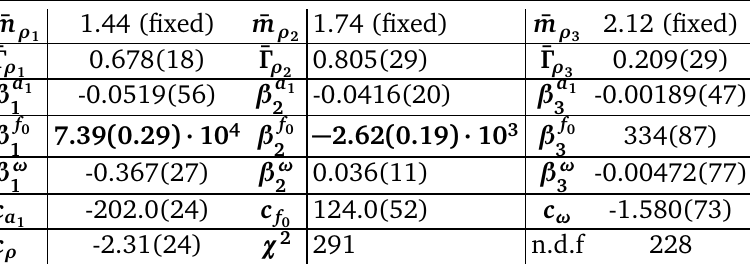
, f , ω and i = 1, 2, 3 ) as well , ( j = a 1 0 i and c in GeV − 2 and c ω in GeV − 1 f 0 a 1